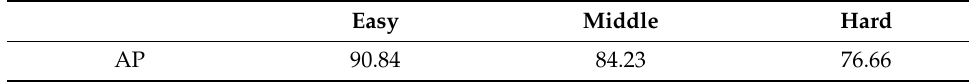
Table 9. The AP of the Bike Recognition (IoU =